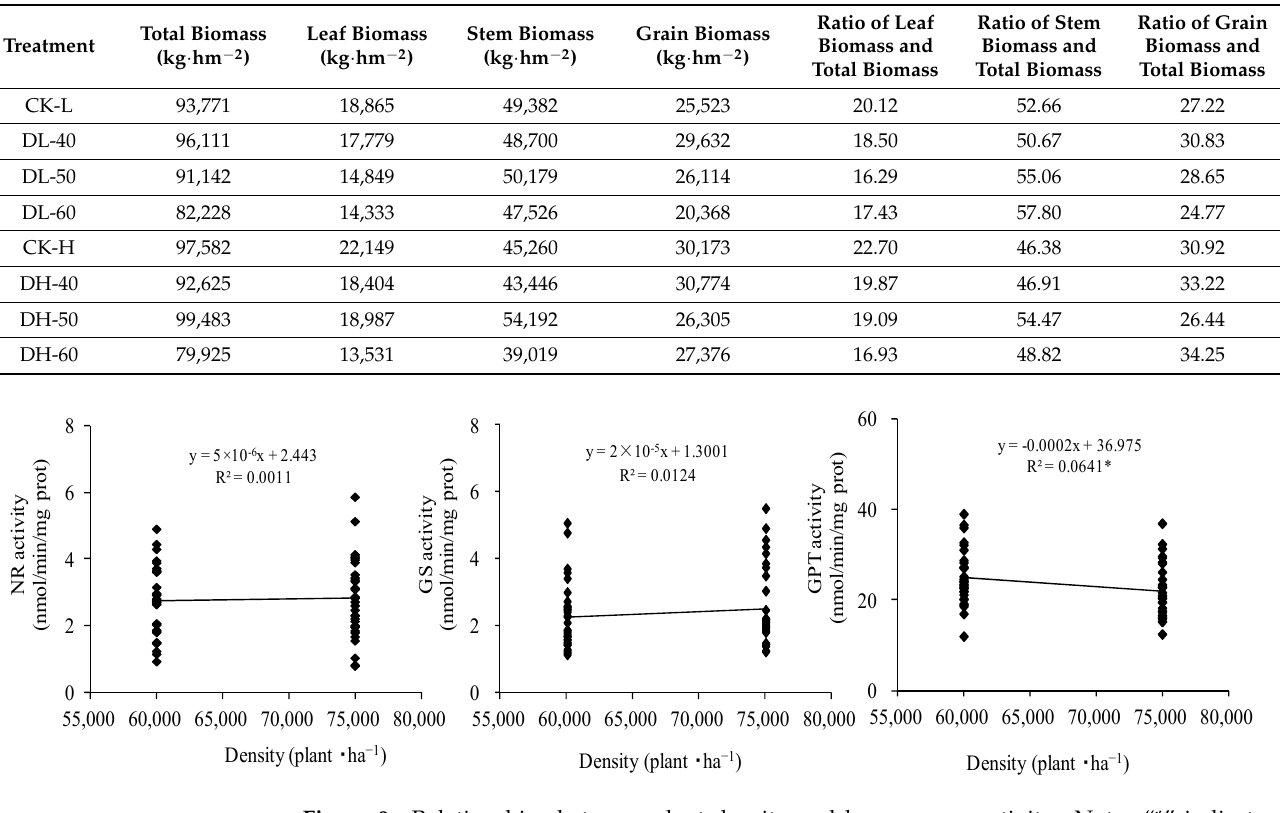
Table 1. Average yield of biomass (fresh-weight yield, kg · hm − 2 ) and the yield component dur- ing 2019–2020.